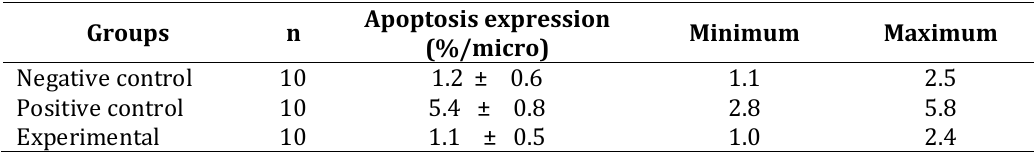
Innovation of nanocurcumin as anti-apoptotic granulosa cells in rat ovaries due to lead acetate exposure (mean ± standard deviation)